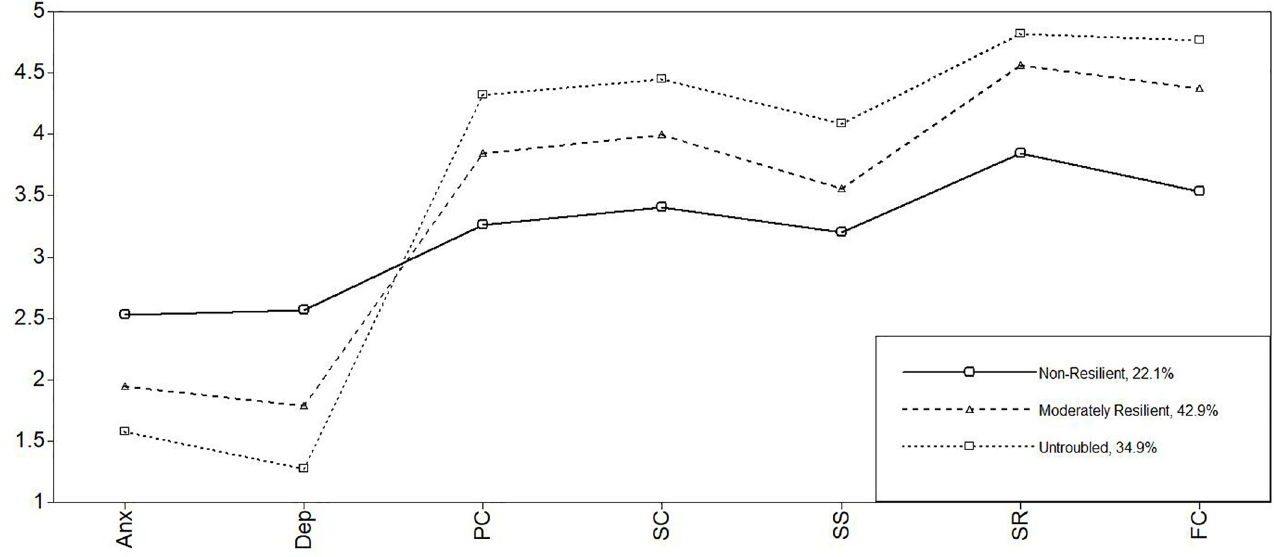
Fig 1. Latent profiles of Switzerland. Note . Anx = anxiety; Dep = depression; PC = personal competence; SC = social competence; SS = structured style; SR = social resources; FC = family cohesion.